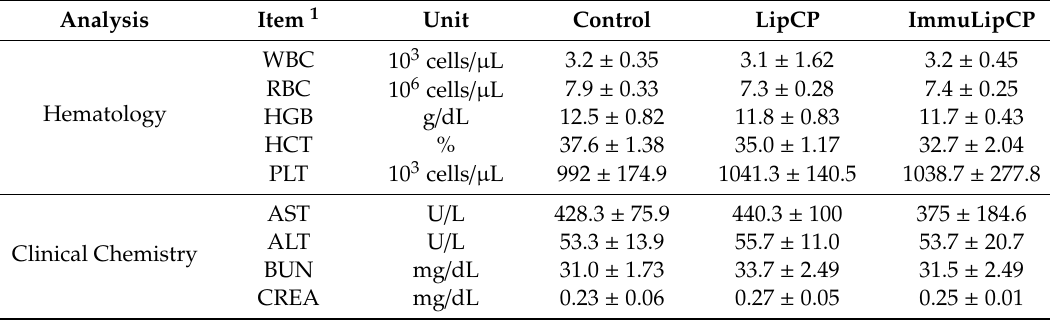
Table 3. Blood analysis for evaluation of systemic toxicity ( n = 5, mean ± SD). Analysis Item 1 Unit Control LipCP ImmuLipCP